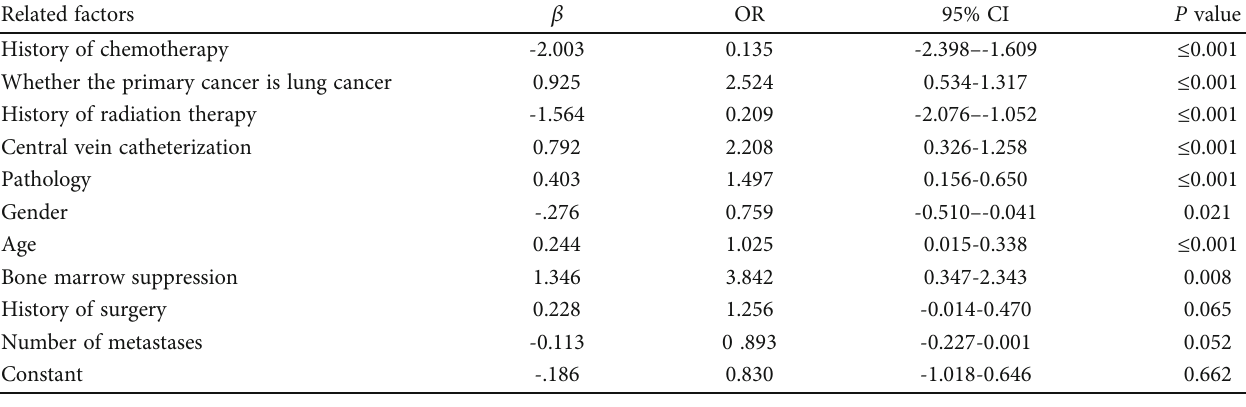
Table 2: Predictors of pulmonary infection in patients with advanced cancer in the fi nal regression model of the training dataset.